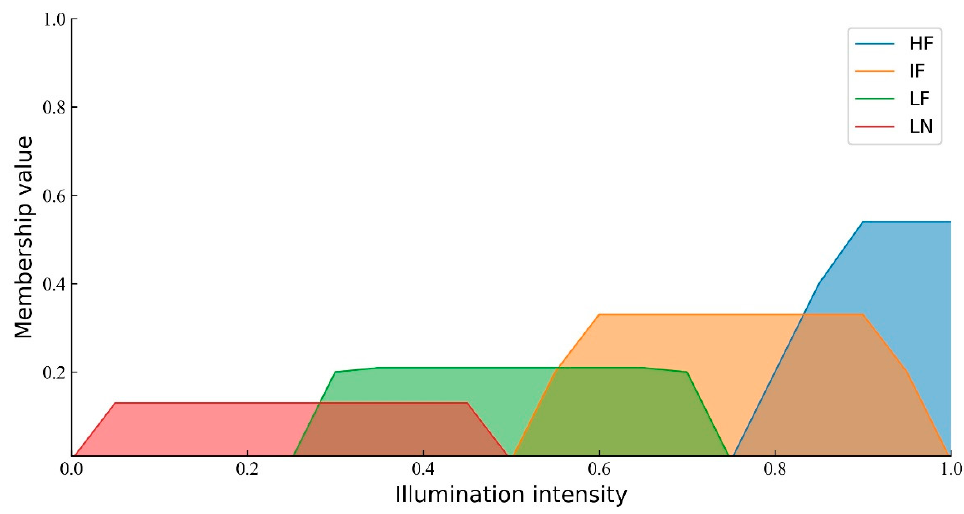
Figure 8. Fuzzy implication rules.